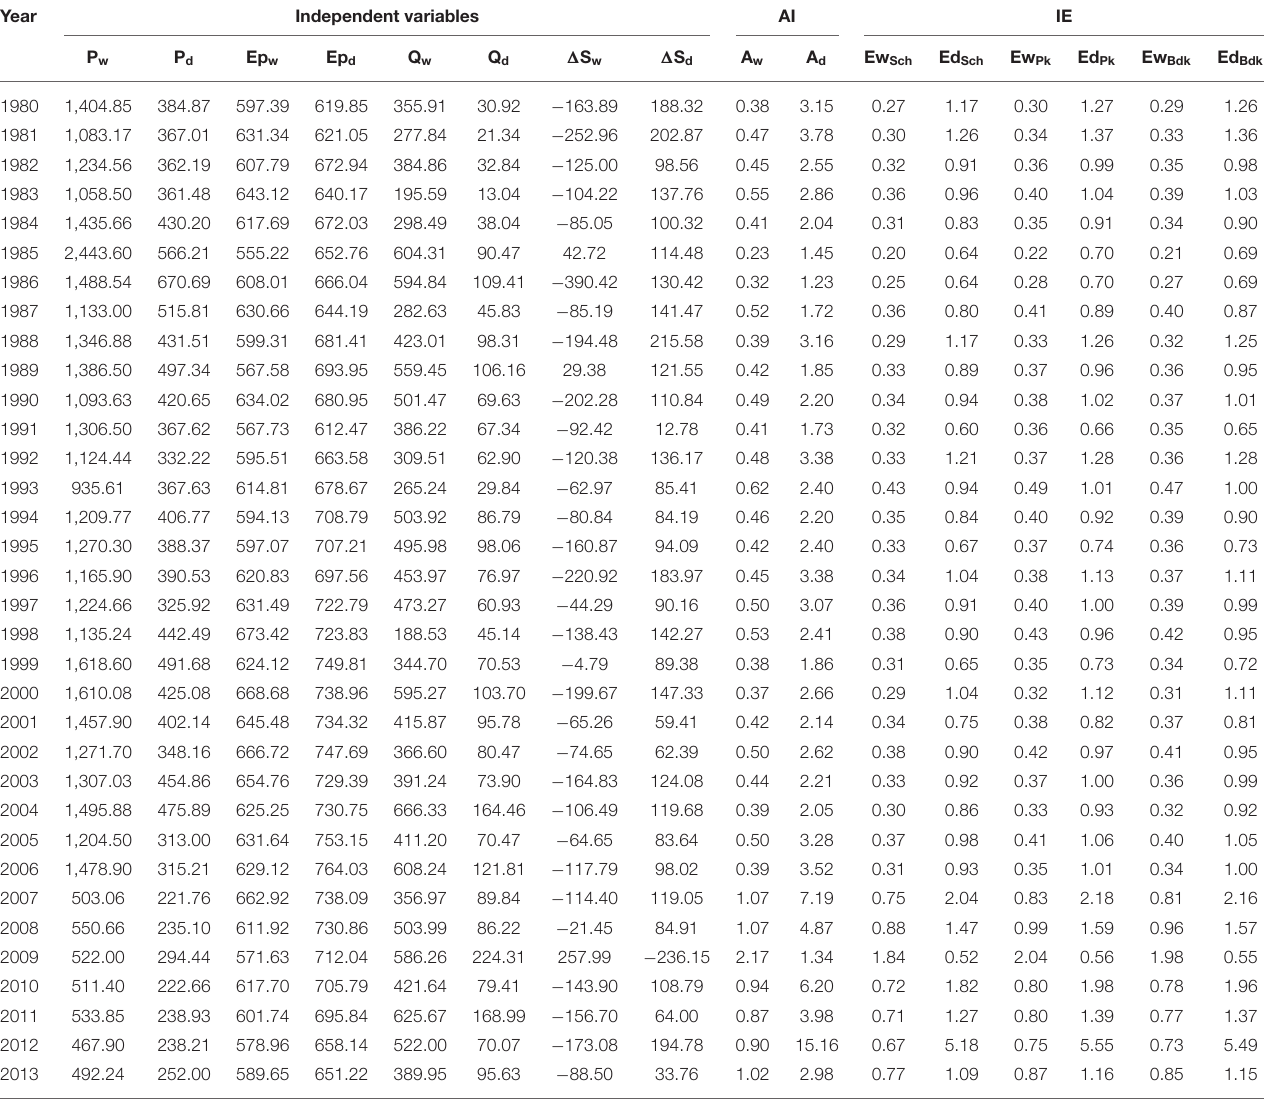
TABLE 4 | Response of the water balance components from 1980 to 2013 in the IRW according to the wet (w) and dry (d) periods, along with the aridity (AI) and evaporative (EI) indices for the IRW. Year Independent